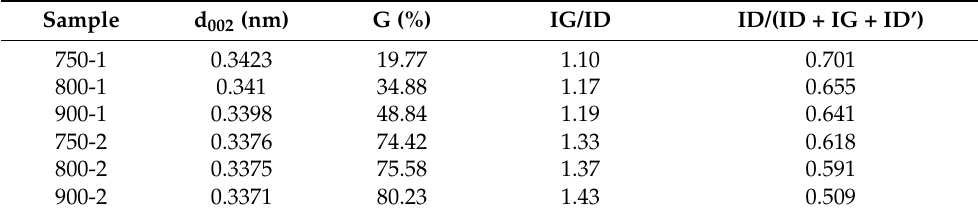
Table 1. Structural parameters were analyzed from the curve of the XRD and Raman spectrum. Sample d 002 (nm)